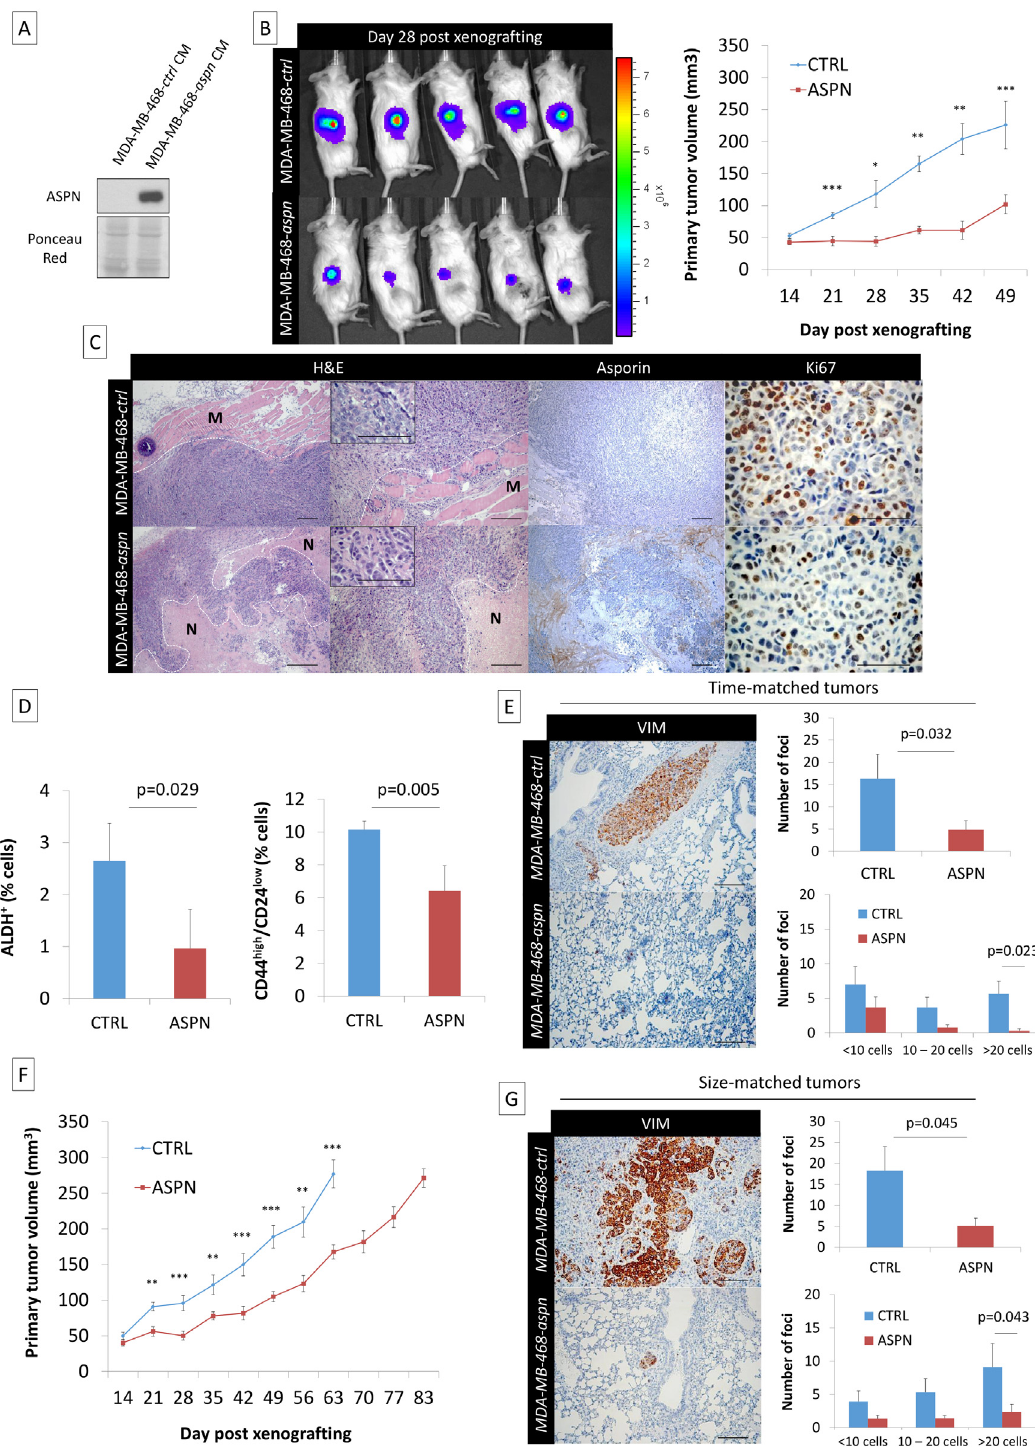
Fig 6. Asporin reduces primary breast cancer tumor growth and lung metastasis formation in vivo. (A) Western blot analysis of asporin expression in the CM of MDA-MB-468 stable clones expressing asporin, used for subcutaneous injection in mice. Ponceau red is shown as loading control. (B) Bioluminescence imaging of control and asporin-expressing xenografts at day 28 after tumor engraftment (left panel). The color scale indicates the fluorescent intensity. The mean ( ± SEM) volume (in cubic millimeters) of primary tumors measured weekly (from day 14 onwards) for the time-matched cohort is also shown ( n = 20 for each group) (right panel). Statistical significance was calculated using Student ’ s t -test ( ** 0.01 < p < 0.001; *** 0.001 < p < 0.0001).